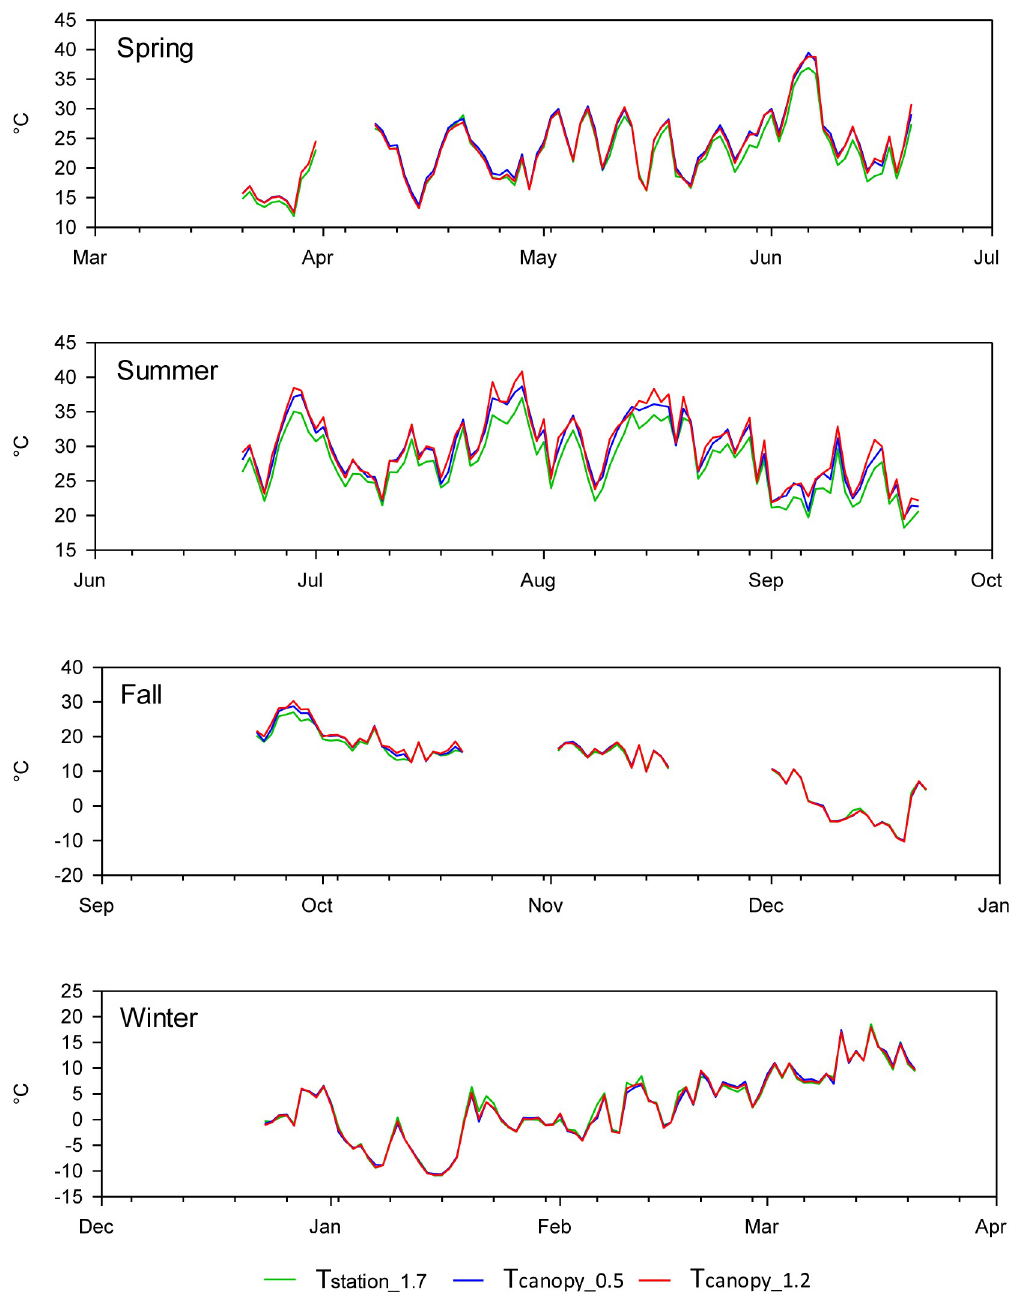
Fig 3. Time series of daily maximum air temperature measured between March 22, 2016, and March 21, 2017, at the weather station (T station_1.7 ), and within the vineyard canopy at a height of 0.5 m (T canopy_0.5 ) and 1.2 m (T canopy_1.2 ) above the ground surface. The linear regression for the 15-minute data showed that during the year, both the daily minimum and daily maximum air temperatures in the canopy and the weather station occurred simultaneously with no lag (Fig 6a). During the summer and winter, both the maximum and minimum air temperature had the same response as the general conditions